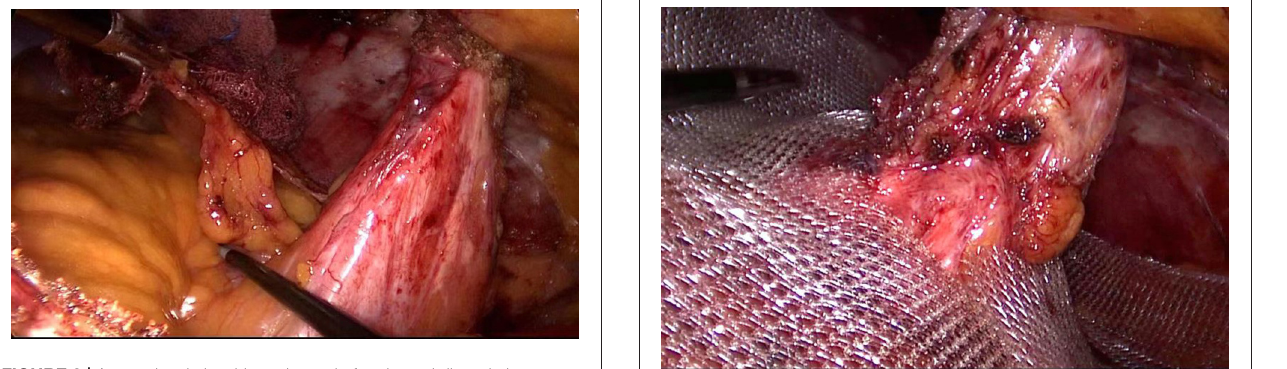
FIGURE 3 | Anatomic relationship at the end of peritoneal dissociation.